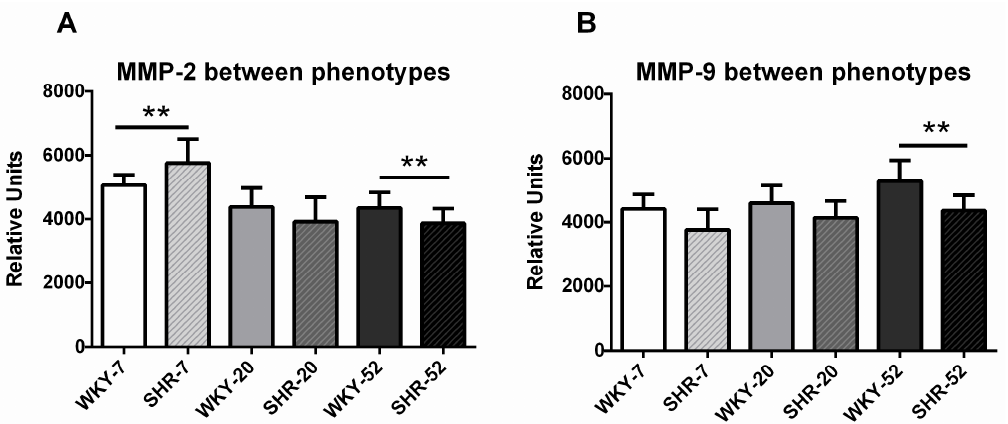
Figure 4. Phenotype di ff erences in MMP-2 ( A ) and MMP-9 ( B ) activity. The data are presented as means ± SD. Statistical significance: ** represents p < 0.01. MMP—matrix metalloproteinase, WKY—Wistar-Kyoto rats, SHR—spontaneously hypertensive rats.